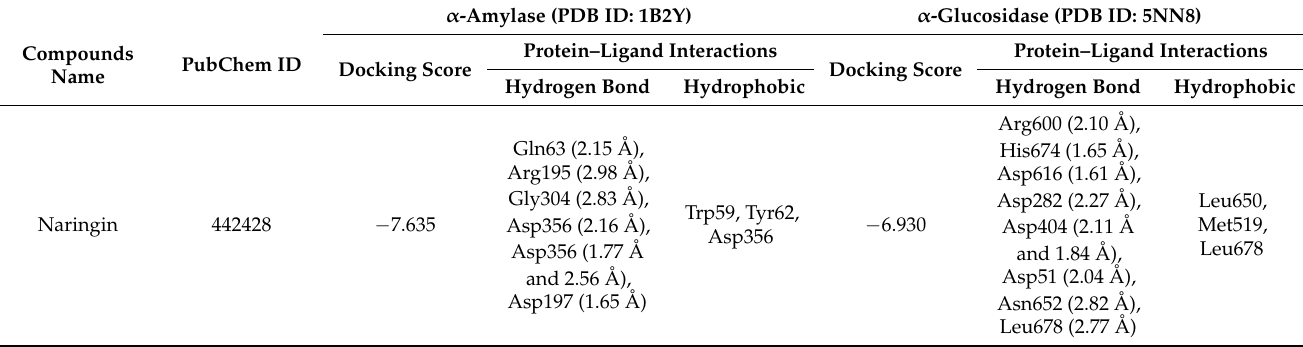
Table 6. Molecular docking interaction energies (kcal/mol) of the acarbose and compounds detected with the LC-MS analysis from the TFE sub-extract against the target enzymes, α -amylase and α -